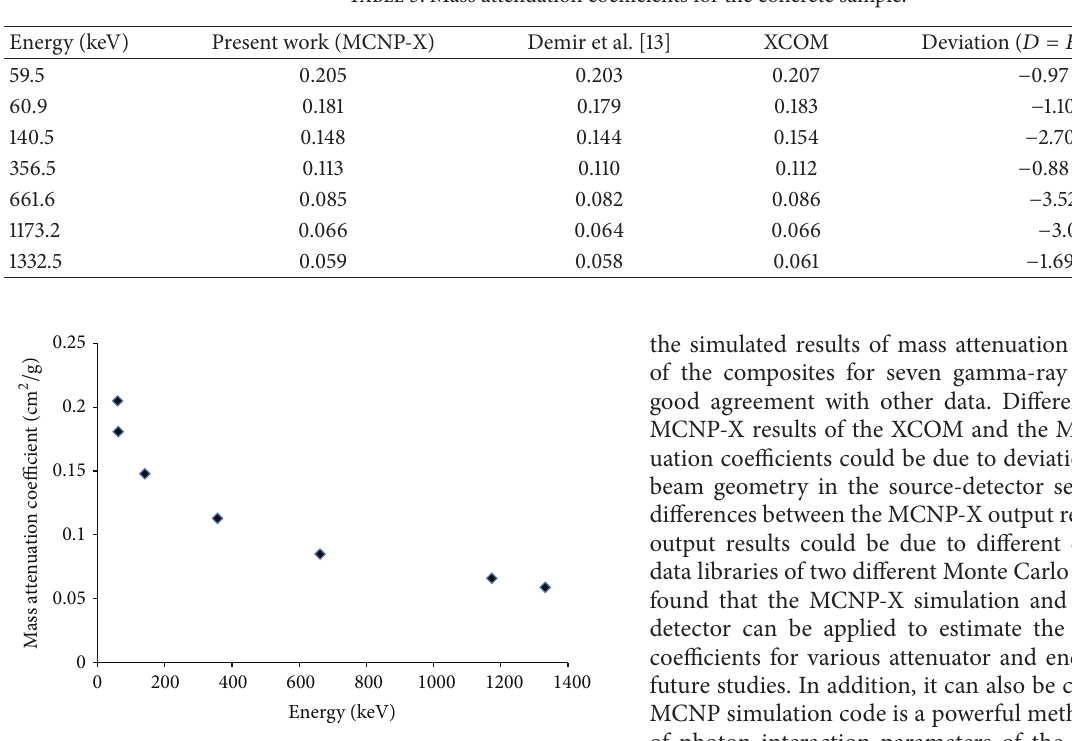
Table 3: Mass attenuation coefficients for the concrete sample.